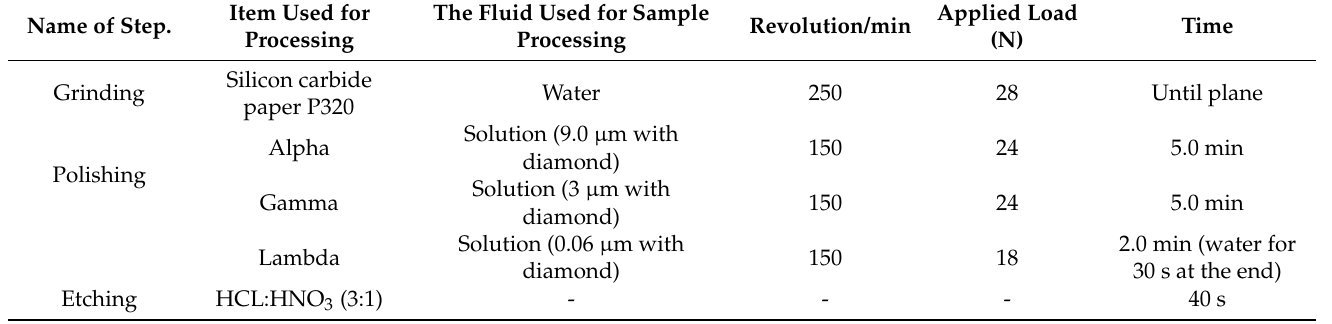
Table 2. Step-by-step procedure to carry out grinding and polishing.